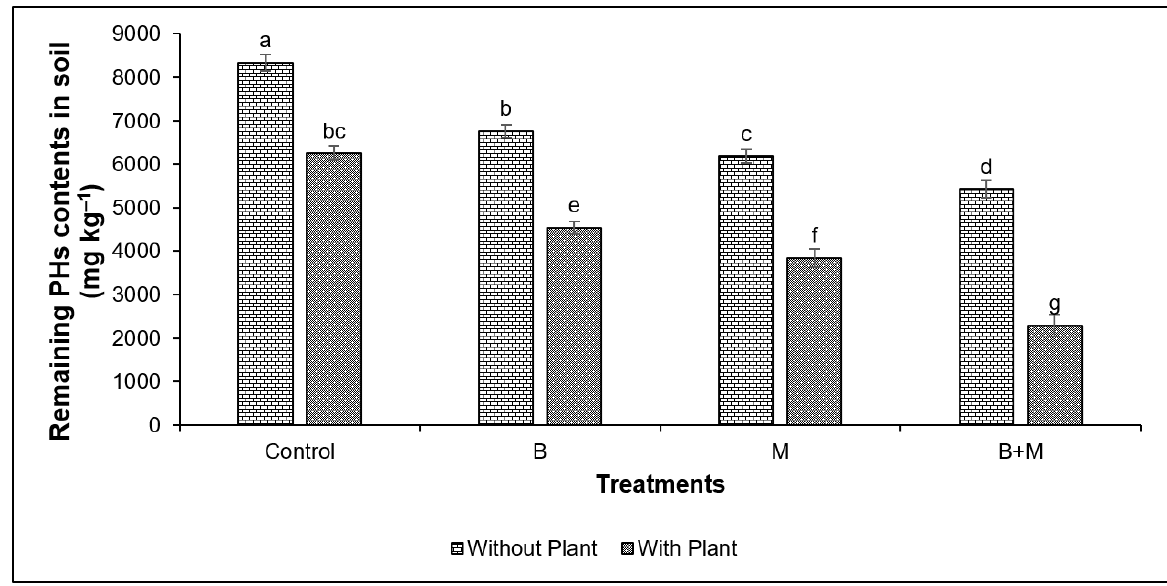
Figure 2. Effect of biochar and Bacillus sp. MN54 on PHs concentrations from diesel contaminated soil. Columns represents the means value and bars represent the standard errors, of triplicates. Means with different letters are significantly different at p ≤ 0.05 according to LSD test. First two columns represent the control treatments with PHs but with or without plants. The second two columns represent the treatments that contains PHs and biochar but with or without plants. Similarly, third two columns represent the treatments that contain PHs and microbes ( Bacillus sp. MN54), but with or without plants. While the last two columns represent the treatments containing PHs, biochar and microbes but with or without plants.